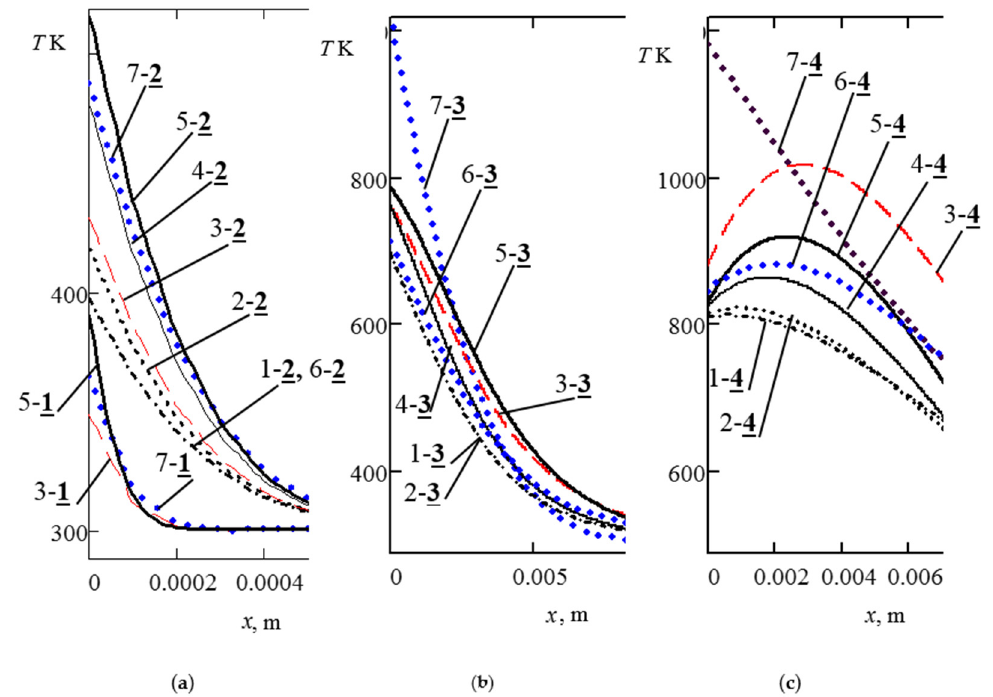
Figure 3. Temperature profiles T ( x , t ) in CC ceramic walls (full made from thermal barrier materials) using Y-PSZ with the porosities causing the selection of optical models for semitransparent M se1 ,…,M se6 (See Table 2, Figure 1a) and opaque M op7 ( b ) TBM under modeling stationary heat load at thermal modes due to heating times t 1 = 0.01 s and t 2 = 0.1 s for diesel engines (See left side of this Figure, a ) and turbines once: at t 3 = 10 s (See middle side, b ); t 4 = 100 s (See right side, c ). The following abbreviation of denoted curves was used, which includes the numbers of optical models together with designation records of thermal modes 1, . . . , 4 (bold and the underline for next digital notations):